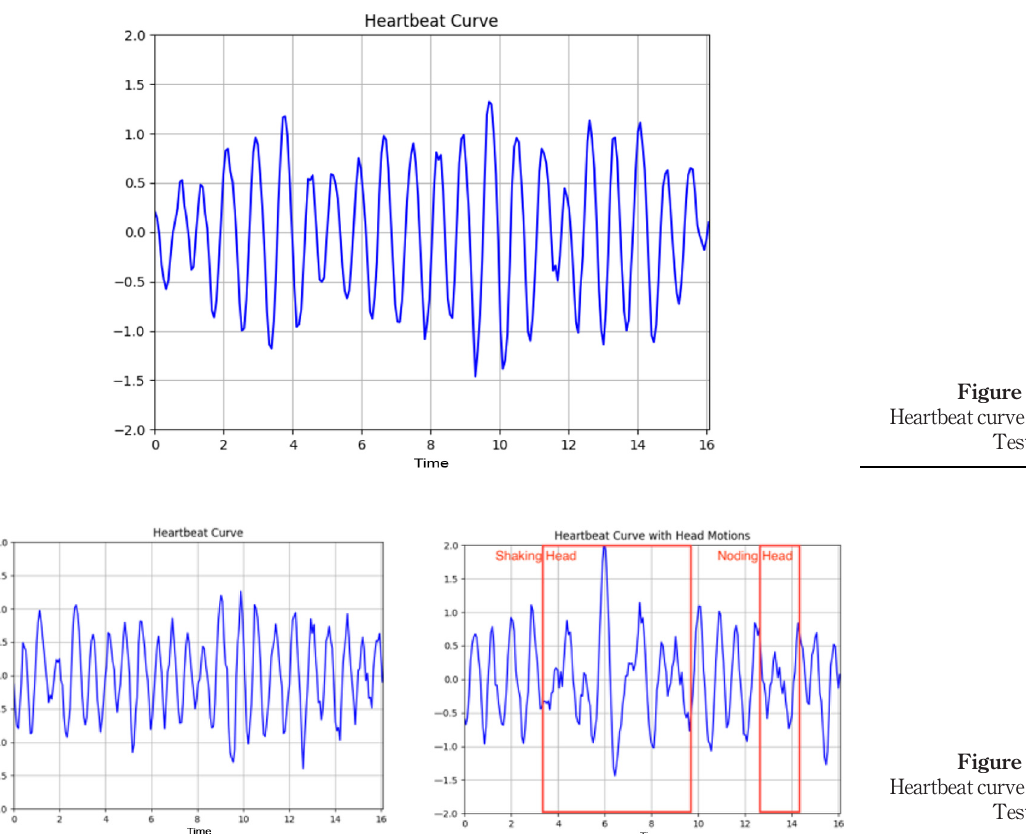
Figure 4. Heartbeat curve